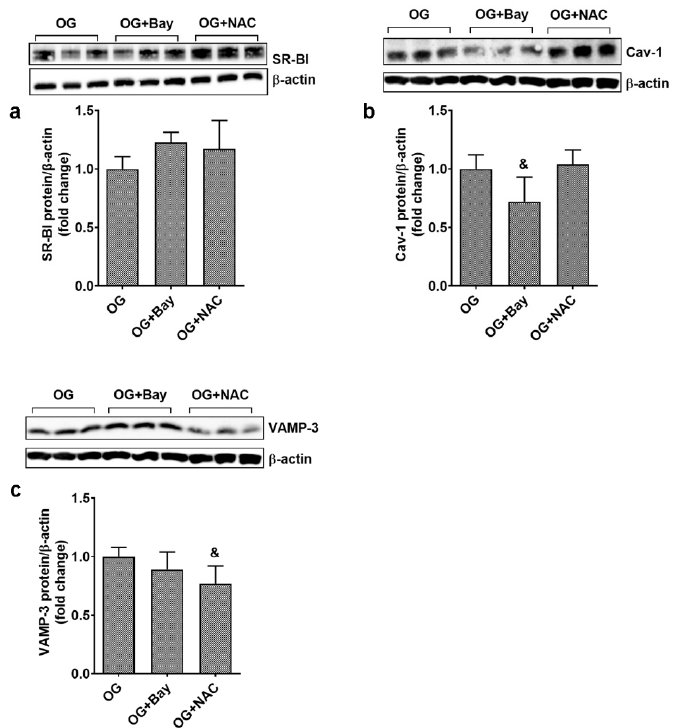
Figure 8. Inhibitors for oxidative stress and NF-kB reduce the expression of Cav-1 and VAMP-3 in ECs exposed to oscillating glucose. Cells were exposed alternatively to 5 mM/25 mM glucose (OG) at every 3 h, for 72 h. N-acetyl-cysteine (NAC, 7.5 mM) or Bay11-7085 (Bay, 15 µM) were added to the OG experimental condition, for the whole period of incubation. ( a – c ) Protein expression of SR-BI ( a ), Cav-1 ( b ) and VAMP-3 ( c ) in EC lysates relative to β -actin (representative blot and densitometric analysis). All data are expressed as fold change versus OG and presented as mean ± SD. & p < 0.05 vs. OG.